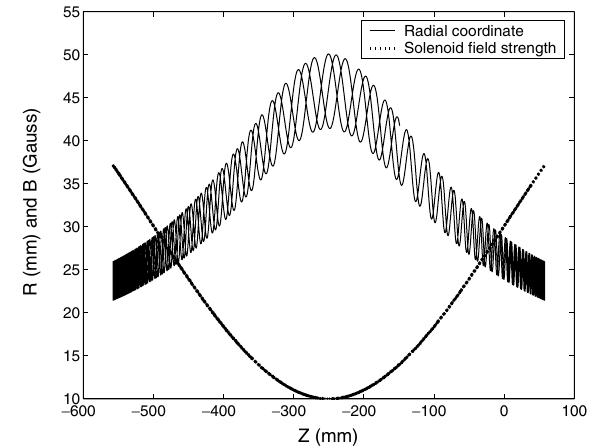
FIG. 16. Two-dimensional orbit of a trapped electron in a sinusoidal solenoid field and the solenoid field strength B along the orbit. Here, R and Z are the radial and longitudinal coordinates,